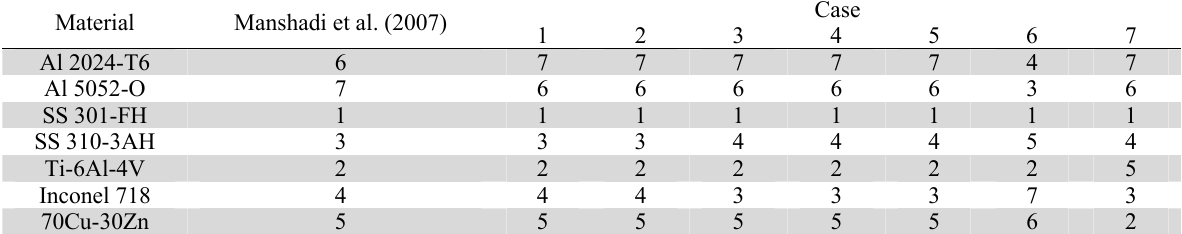
Rankings of cryogenic storage tank materials using VIKOR method for seven